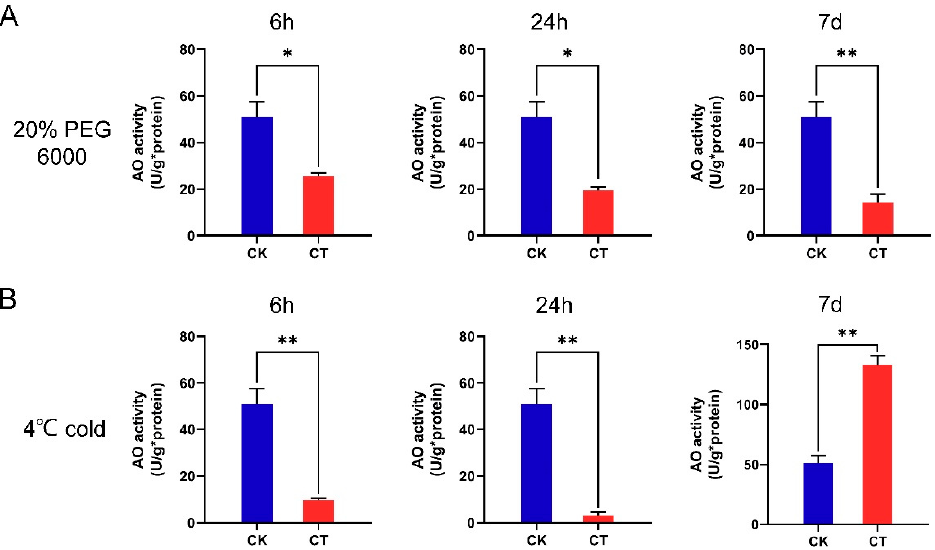
Figure 7. AO activity measurement of the A. nanus leaves under osmotic and cold stress. ( A ) AO activities of leaves of A. nanus under osmotic stress. ( B ) AO activities of leaves of A. nanus under cold stress. Values are expressed as means ± SD ( n = 3), and statistically significant differences were evaluated using Student’s t-test, * p < 0.05, ** p < 0.01.